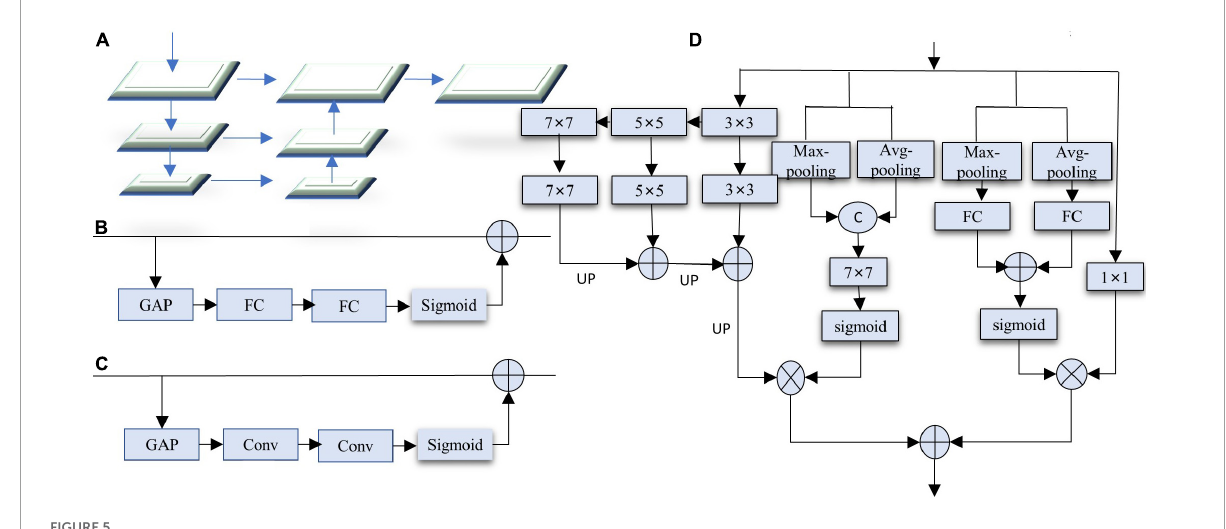
FIGURE5 (A) Feature pyramid network (FPN). (B) Channel attention (CA). (C) Spatial attention (SA). (D) Our SC-FP module. For brevity, the batch normalization and activation functions are not marked.